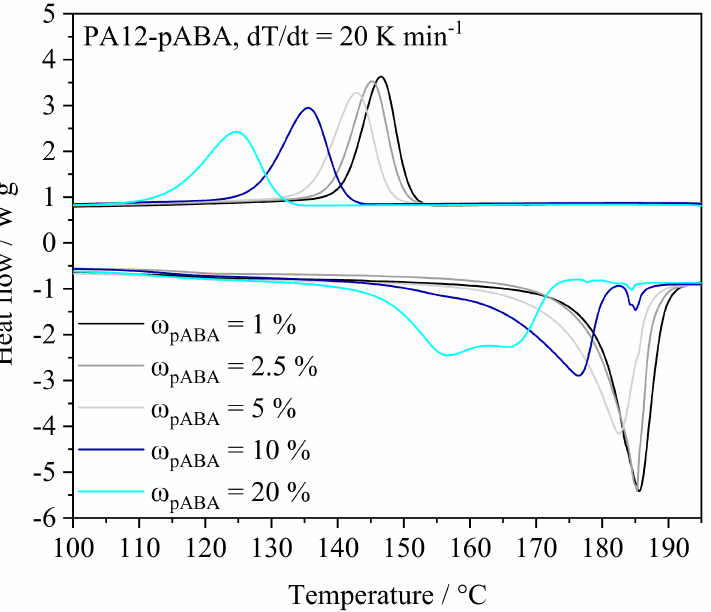
Figure 4. Adapted thermal characteristics of powder blends exhibiting varying mass fractions of pABA, n =